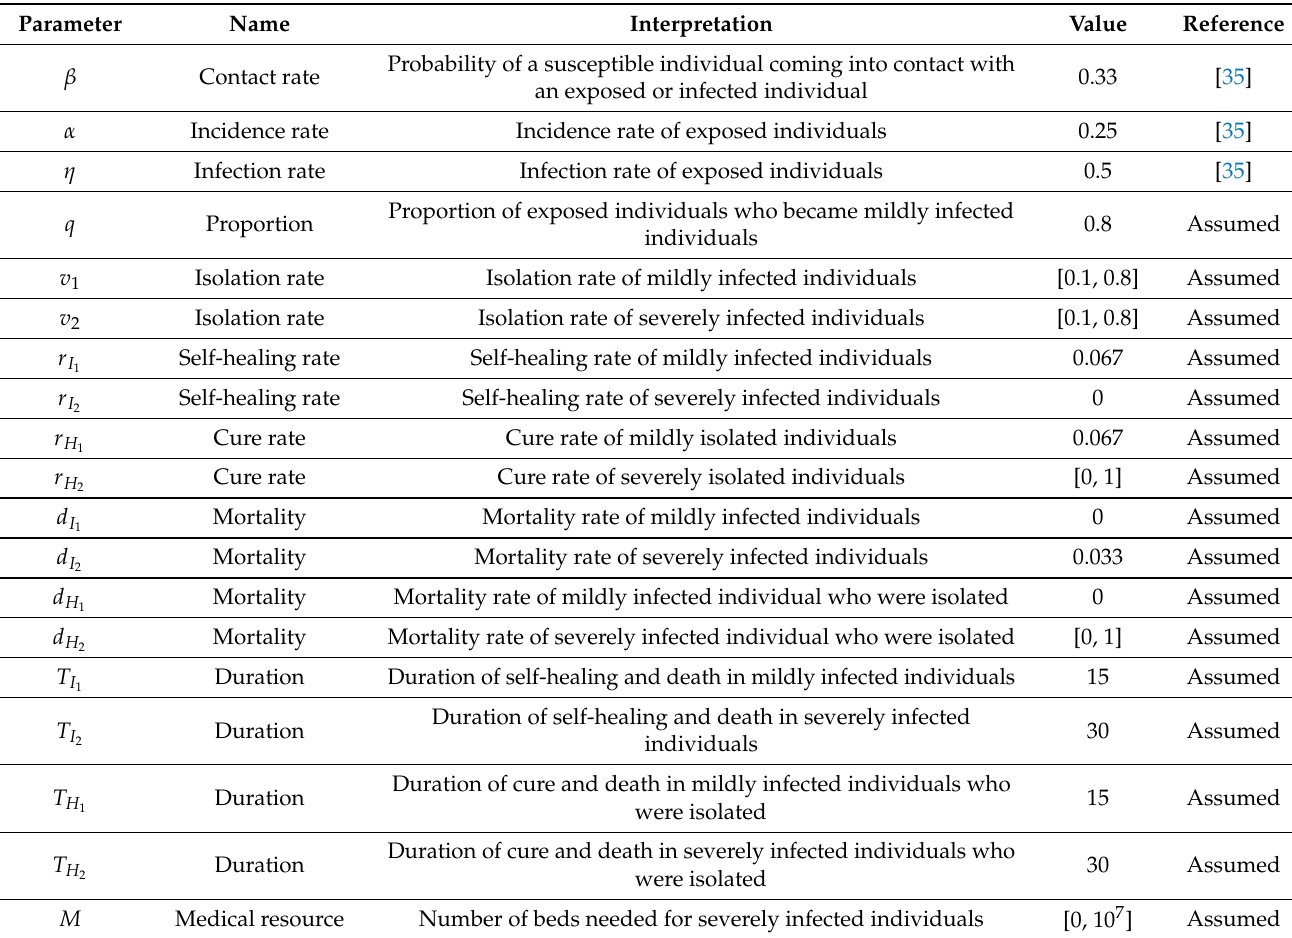
Table 1. Descriptions of the variables and